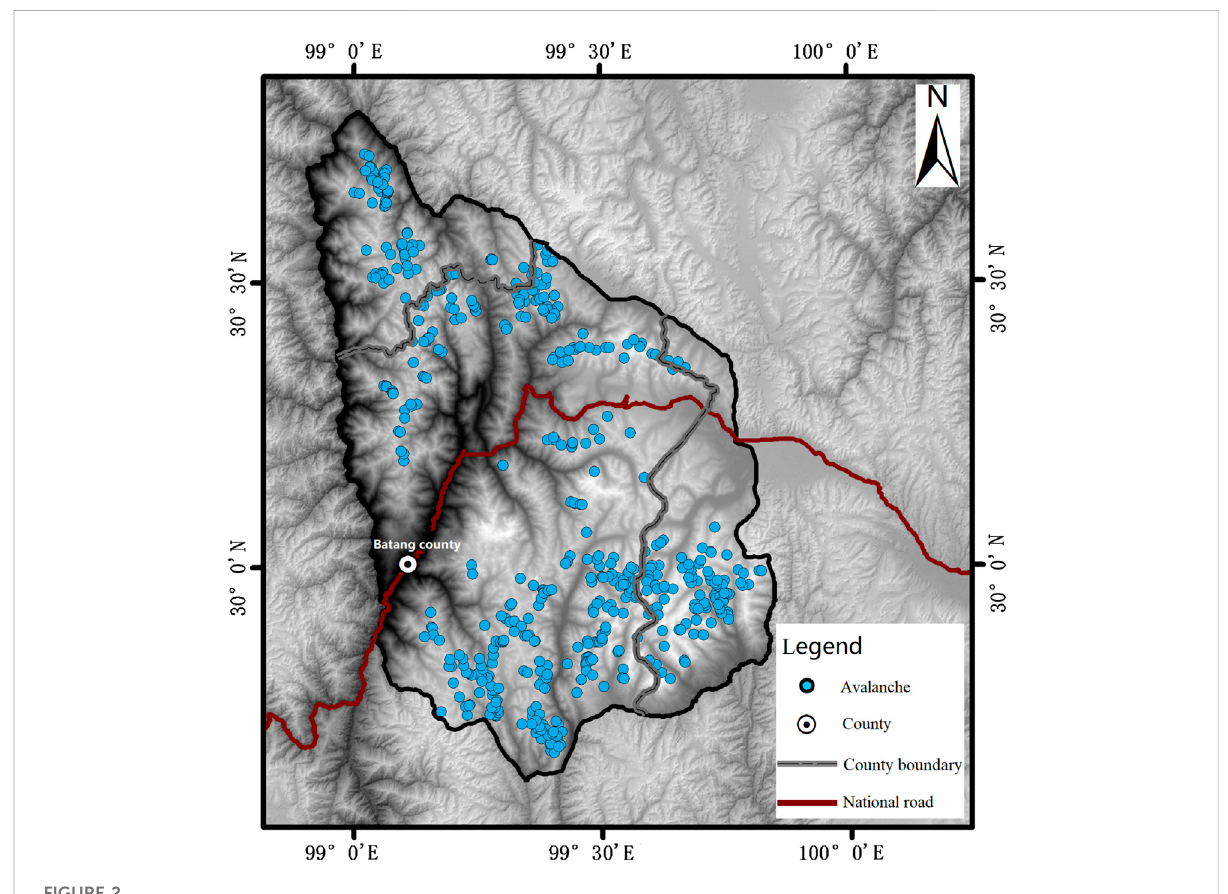
FIGURE 2 Distribution of investigated avalanche locations in study area.